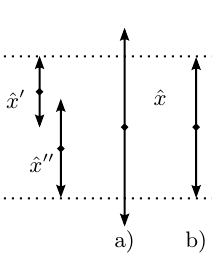
Figure 3: Improved merge operation